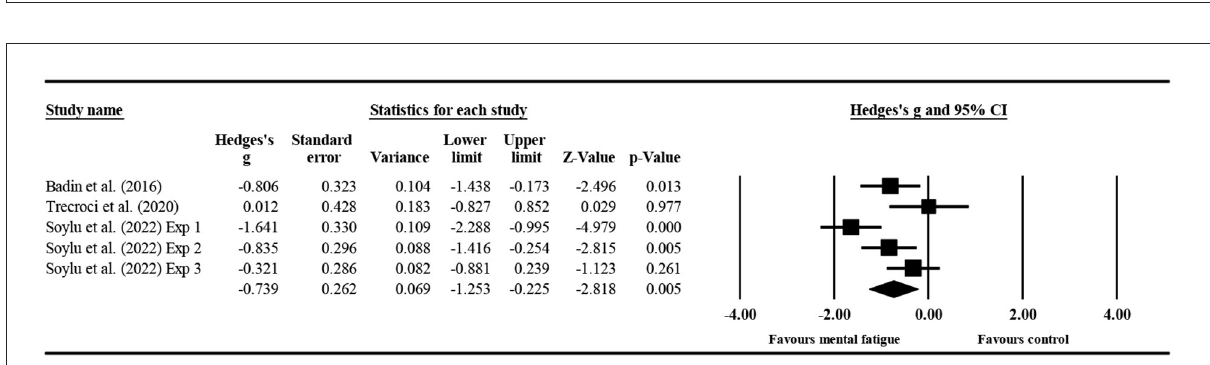
FIGURE7 Forest plot of changes in the total number of tackles with the comparison of two conditions (mental fatigue and control condition). The results displayed are effect sizes with 95% CIs.